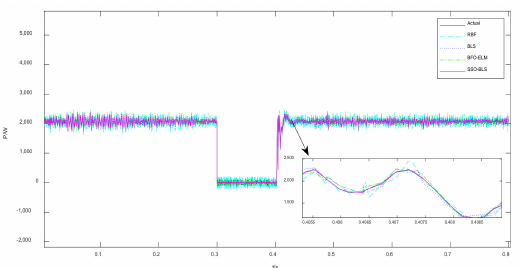
Figure 5. Power comparison of DC microgrids grid-connected points in AC grids with three–phase short–circuit fault.